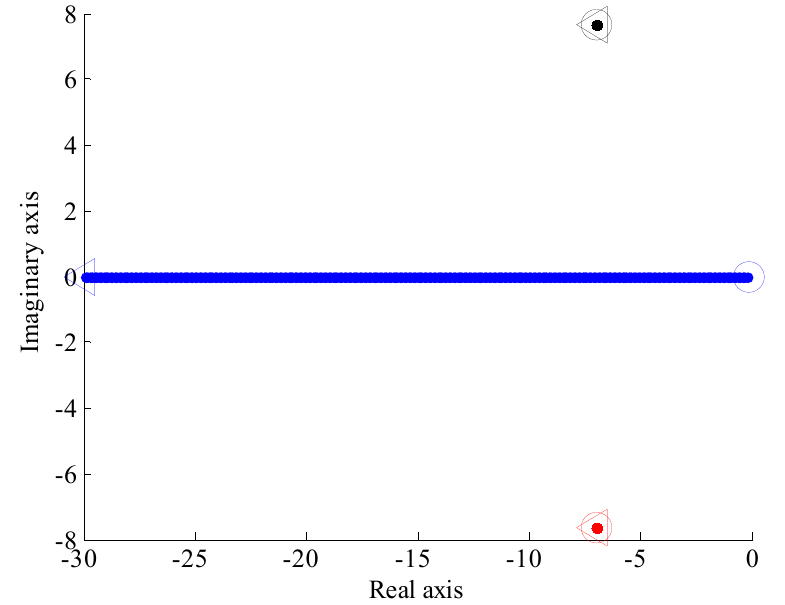
Figure 14. Location of the poles for the assistive toilet system for a virtual damping c v varying from 1 Ns/m (circle) to 300 Ns/m (triangle), m v = 10 kg, T = 0.08 s, K p = 50.